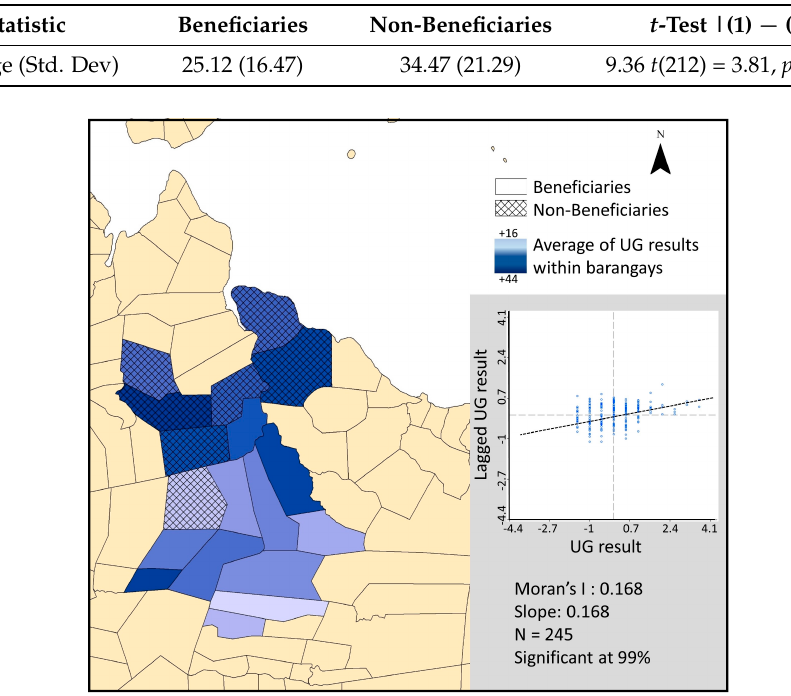
Figure 3. The average values of the ultimatum game (UG) result at Barangay level, and Global Moran’s I plot.